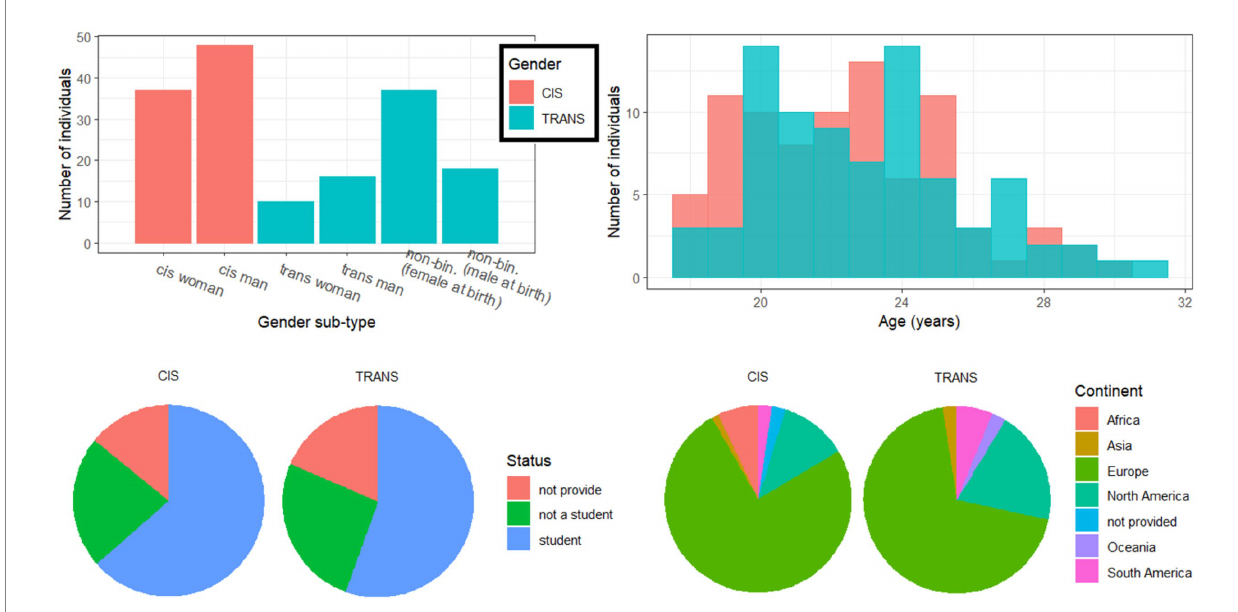
FIGURE 1 Demographics of the two groups of participants, split by sub-type of gender identity (top left), age at time of testing (top right), student status (bottom left) and geographical origin (bottom